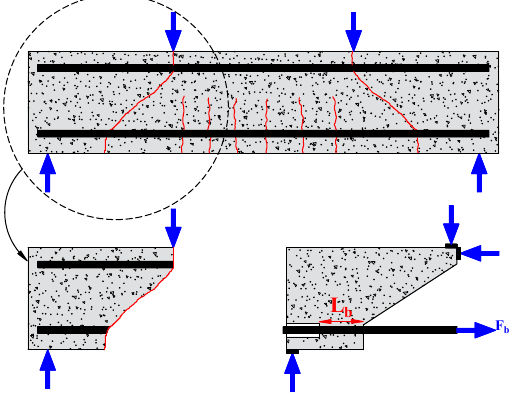
Figure 11. Modified Beam test by Hanjari et al. [29].